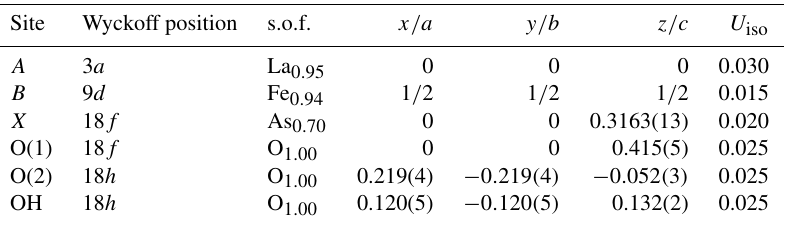
Table 4. Sites, Wyckoff positions, site occupancy factors (s.o.f.), fractional atomic coordinates, and isotropic displacement parameters (in Å 2 ) for